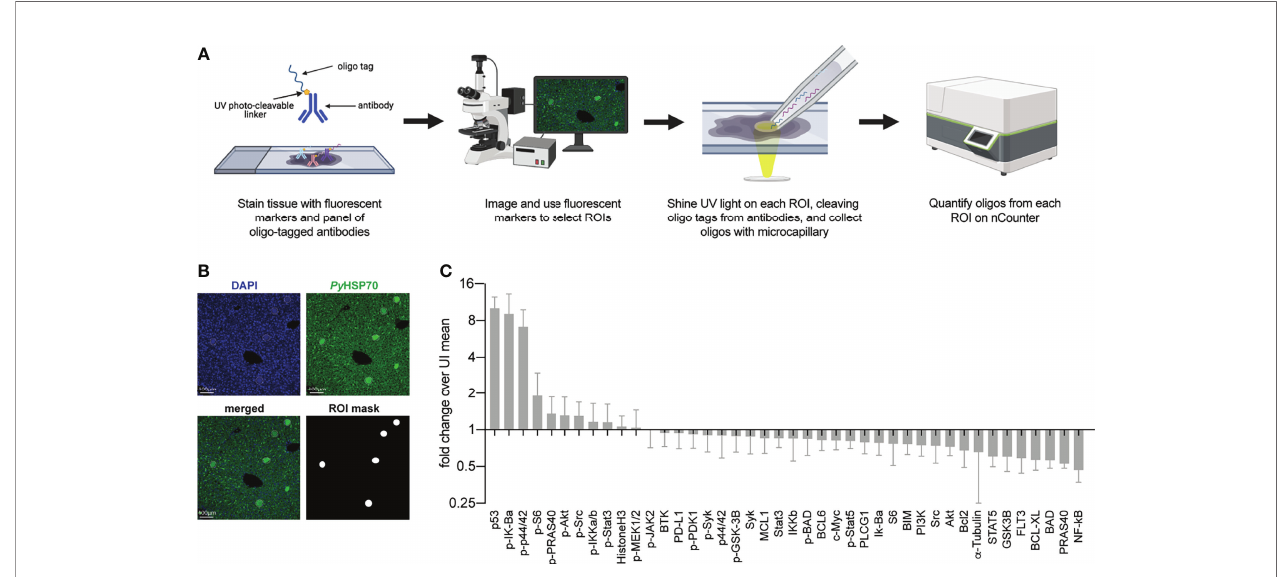
FIGURE 1 | Digital Spatial Pro fi ling facilitates evaluation of proteins and post-translational modi fi cations in Plasmodium yoelii infected tissue. (A) Schematic of DSP methodology. (B) Representative images of fl uorescent staining of liver sections from uninfected or P. yoelii -infected mice at 44hpi. Parasites are stained with Py HSP70 in green and DAPI is shown in blue. Data were pooled from regions of interest indicated by white circles. (C) Signal from P. yoelii -infected mice normalized to ROI area and to the average signal from uninfected mice. Error bars indicate standard deviation. n = 7-8 mice per group with one pooled ROI measured from each